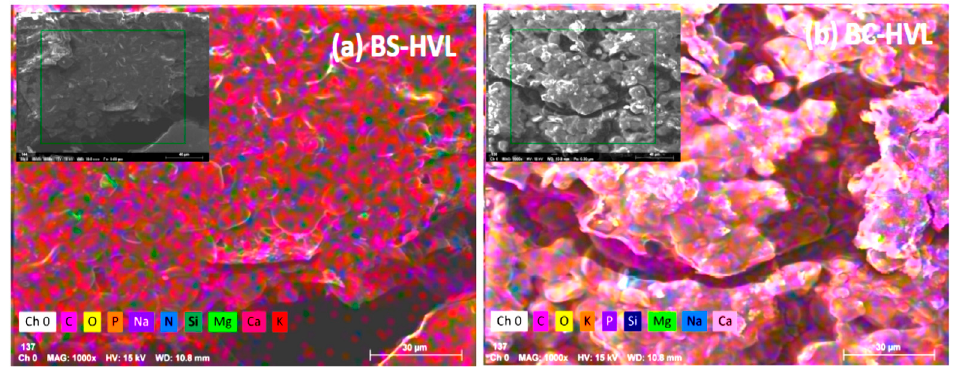
Figure 4. SEM (scanning electron microscopy) micrographs before adsorption of the dye on BS-HVL ( a ) and BC-HVL ( b ).